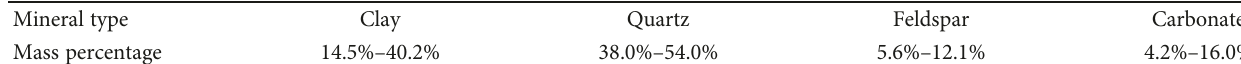
Table 3: Mineral composition.